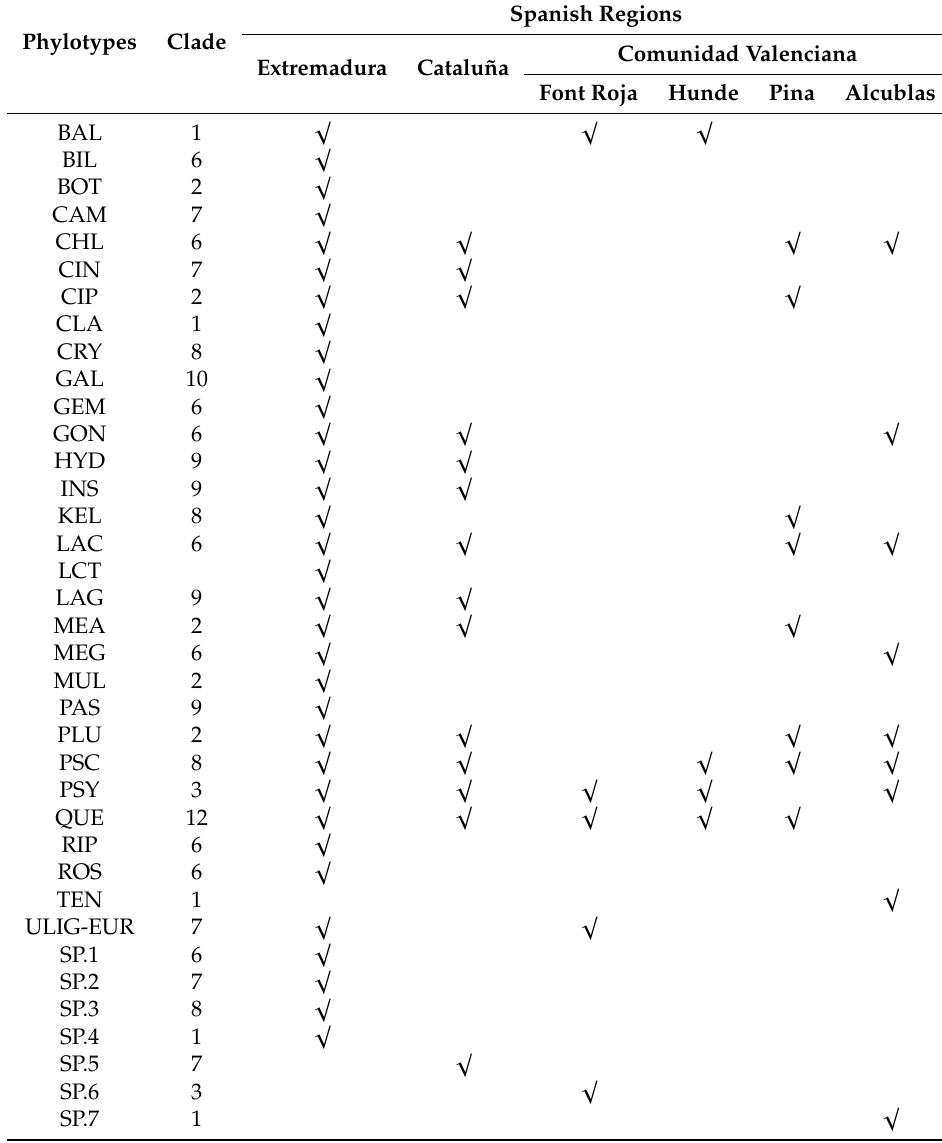
Table 1. Phytophthora phylotypes detected by next generation sequencing (NGS), based on the Internal Transcribed Spacer (ITS1)